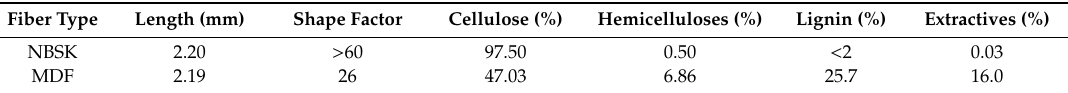
Table 3. Characteristics of Northern bleached softwood Kraft (NBSK) and medium density fiberboard (MDF) cellulosic fibers. Reprinted from Ding et al. [138]. Copyright (2020), with permission from